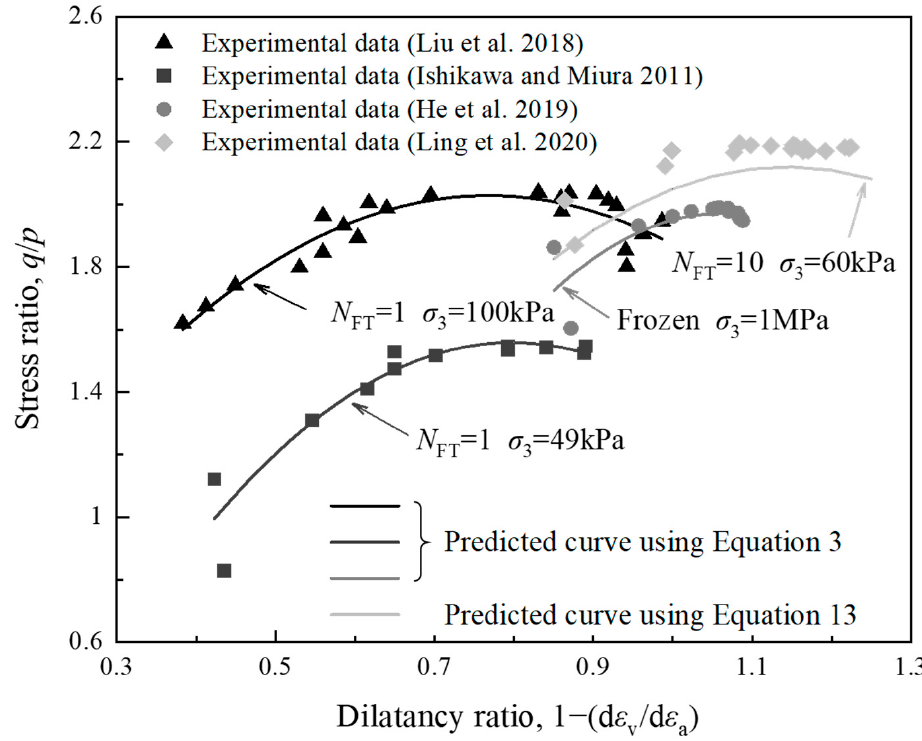
Figure 5. Comparison between predicted and experimental values of stress ratio and dilatancy ratio.